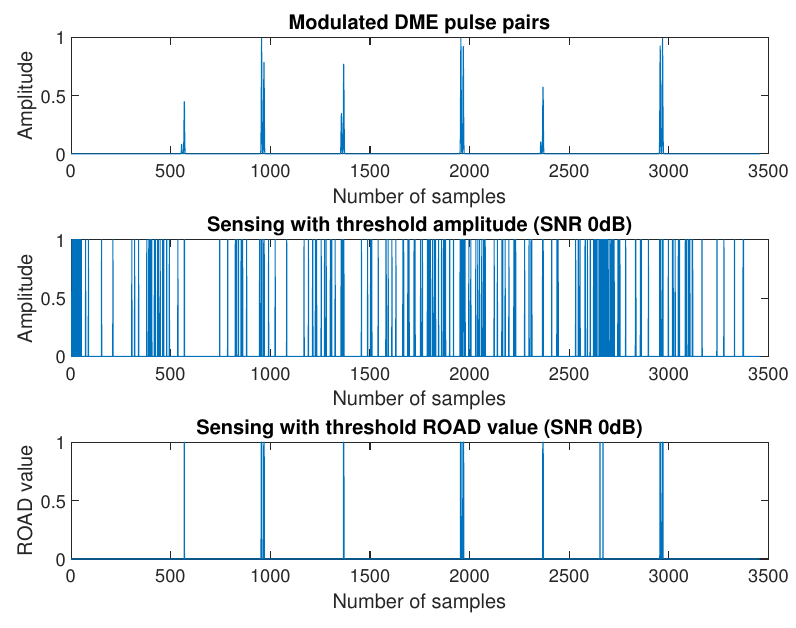
Figure 12. DME interference ( Top ), threshold amplitude-based sensing ( Middle ) and threshold ROAD value-based sensing ( Bottom ) for an SNR of 0 dB.